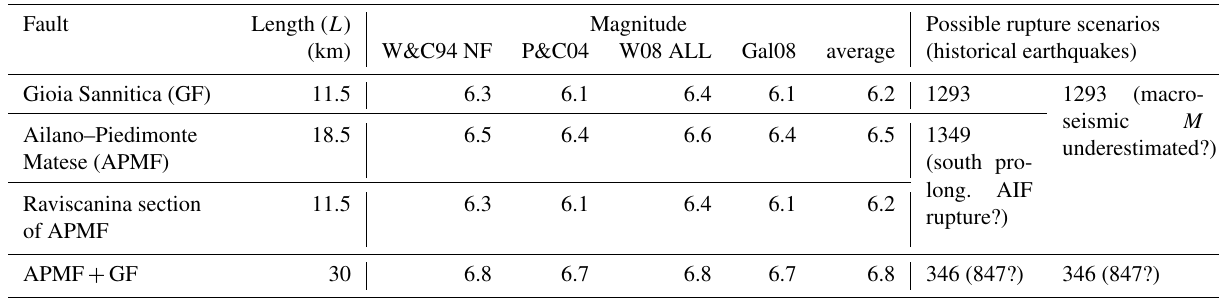
seismic long. AIF